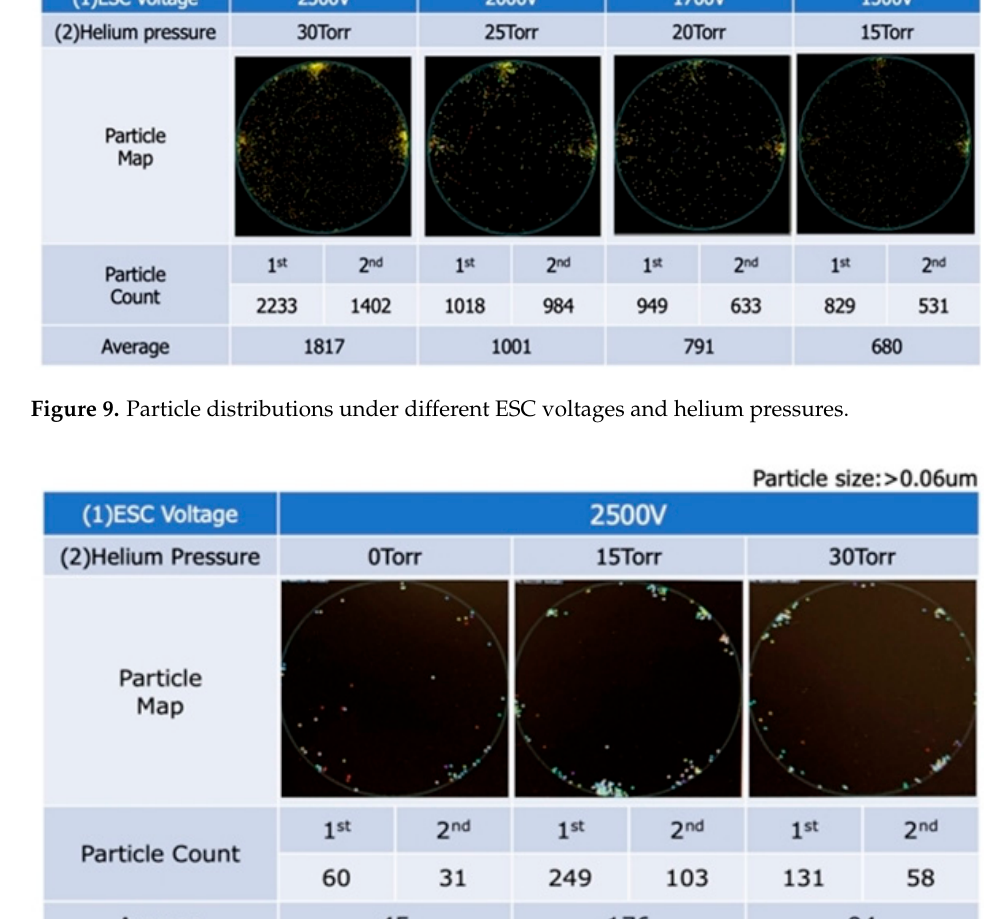
Figure 8. (1) ESC voltages (2500, 2000, 1700, and 1500 V) and (2) helium pressures for the ESC (30, 25, 20, and 15 Torr).